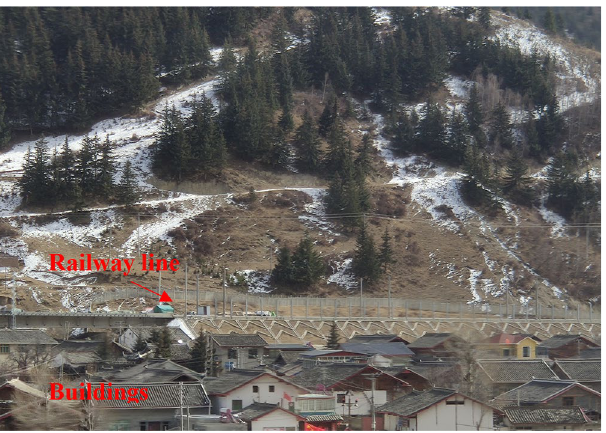
Figure 1. Railway line and surrounding